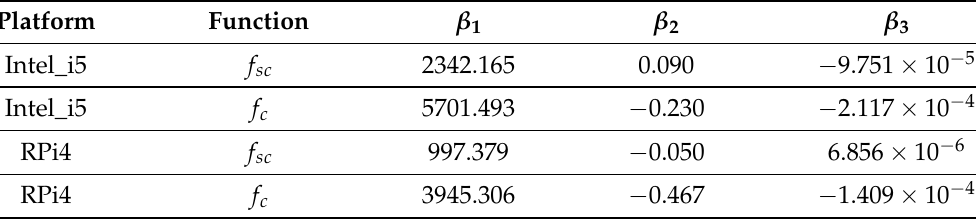
Table 5. Summary of coefficients for f sc (cipher text) and f c (plain text) functions. Both regression functions are under the form F = β 1 + m β 2 + m 2 β 3 .